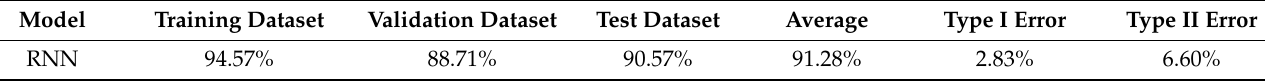
Table 10. Accuracy of the RNN model.